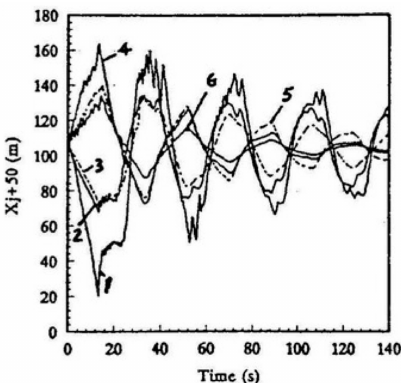
Figure 16. Fluctuation attenuation of the free surface pressurized flow (FSPF) in an SCTT under di ff erent operating conditions [33].